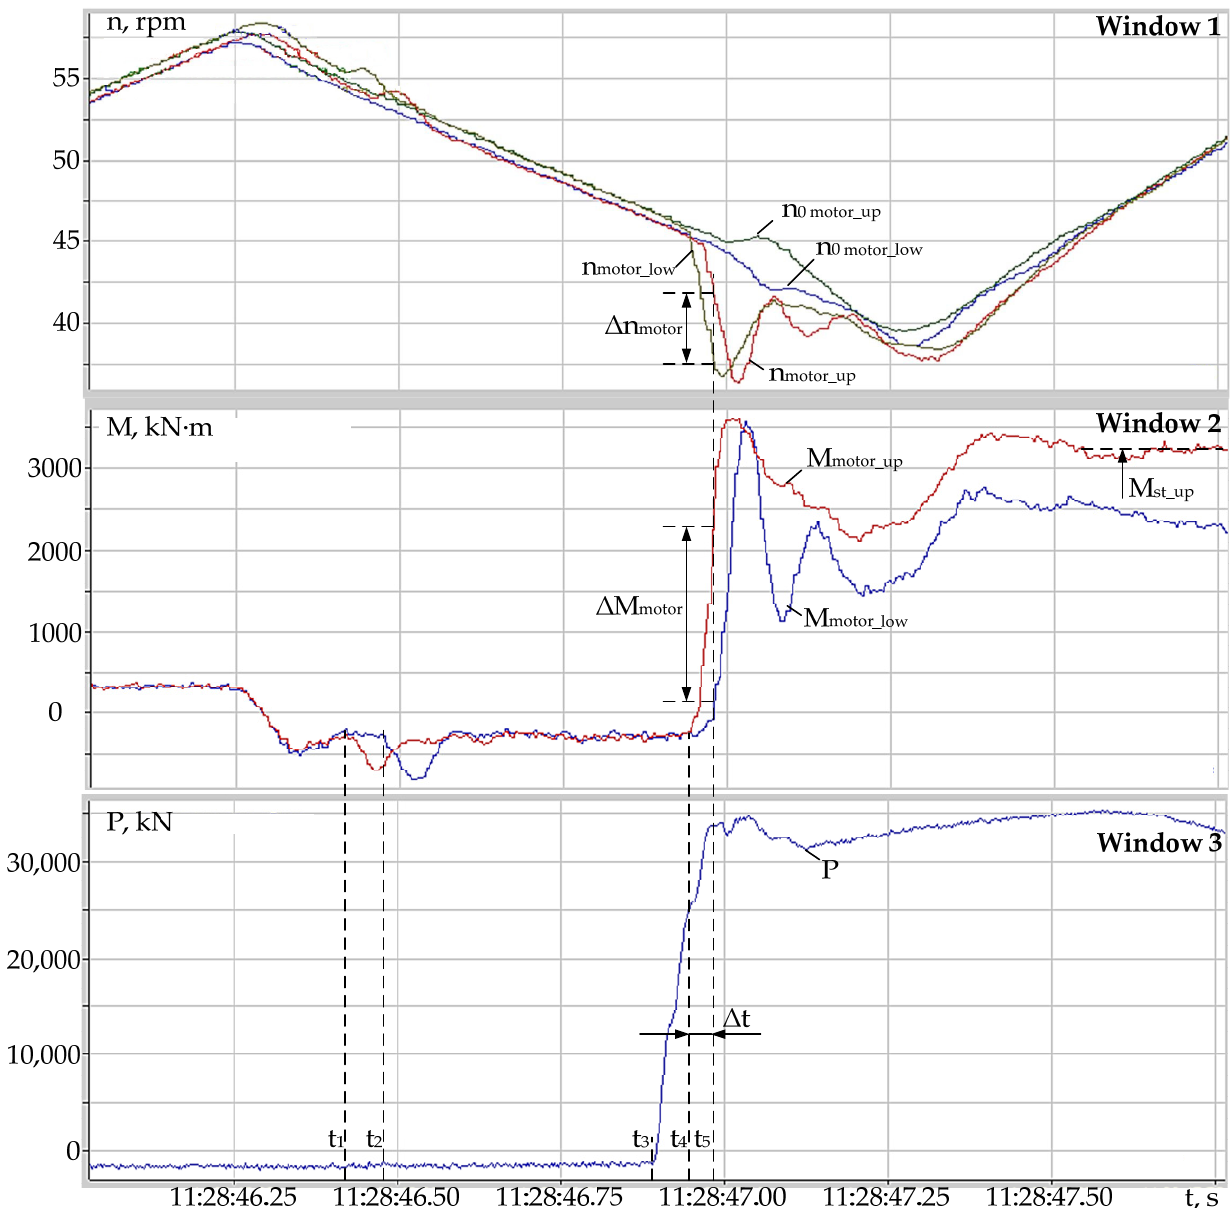
Figure 9. Biting with different UMD and LMD spindle angular gaps.